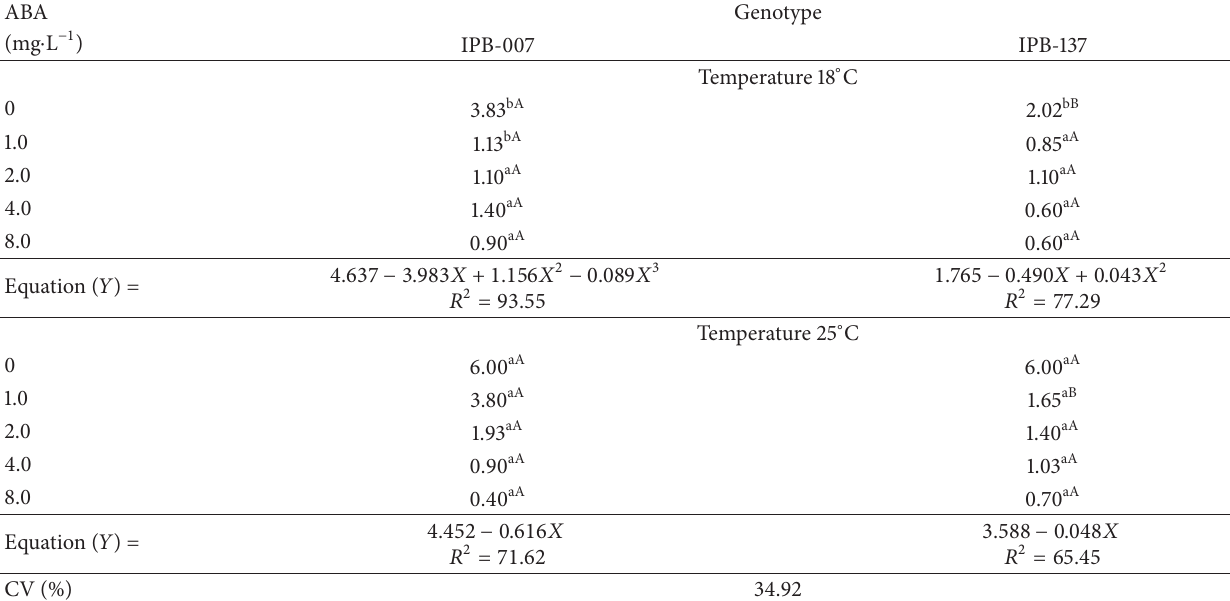
Table 2: Height of sweet potato plant shoots after 180 days of in vitro conservation as a function of abscisic acid concentration, temperature, and